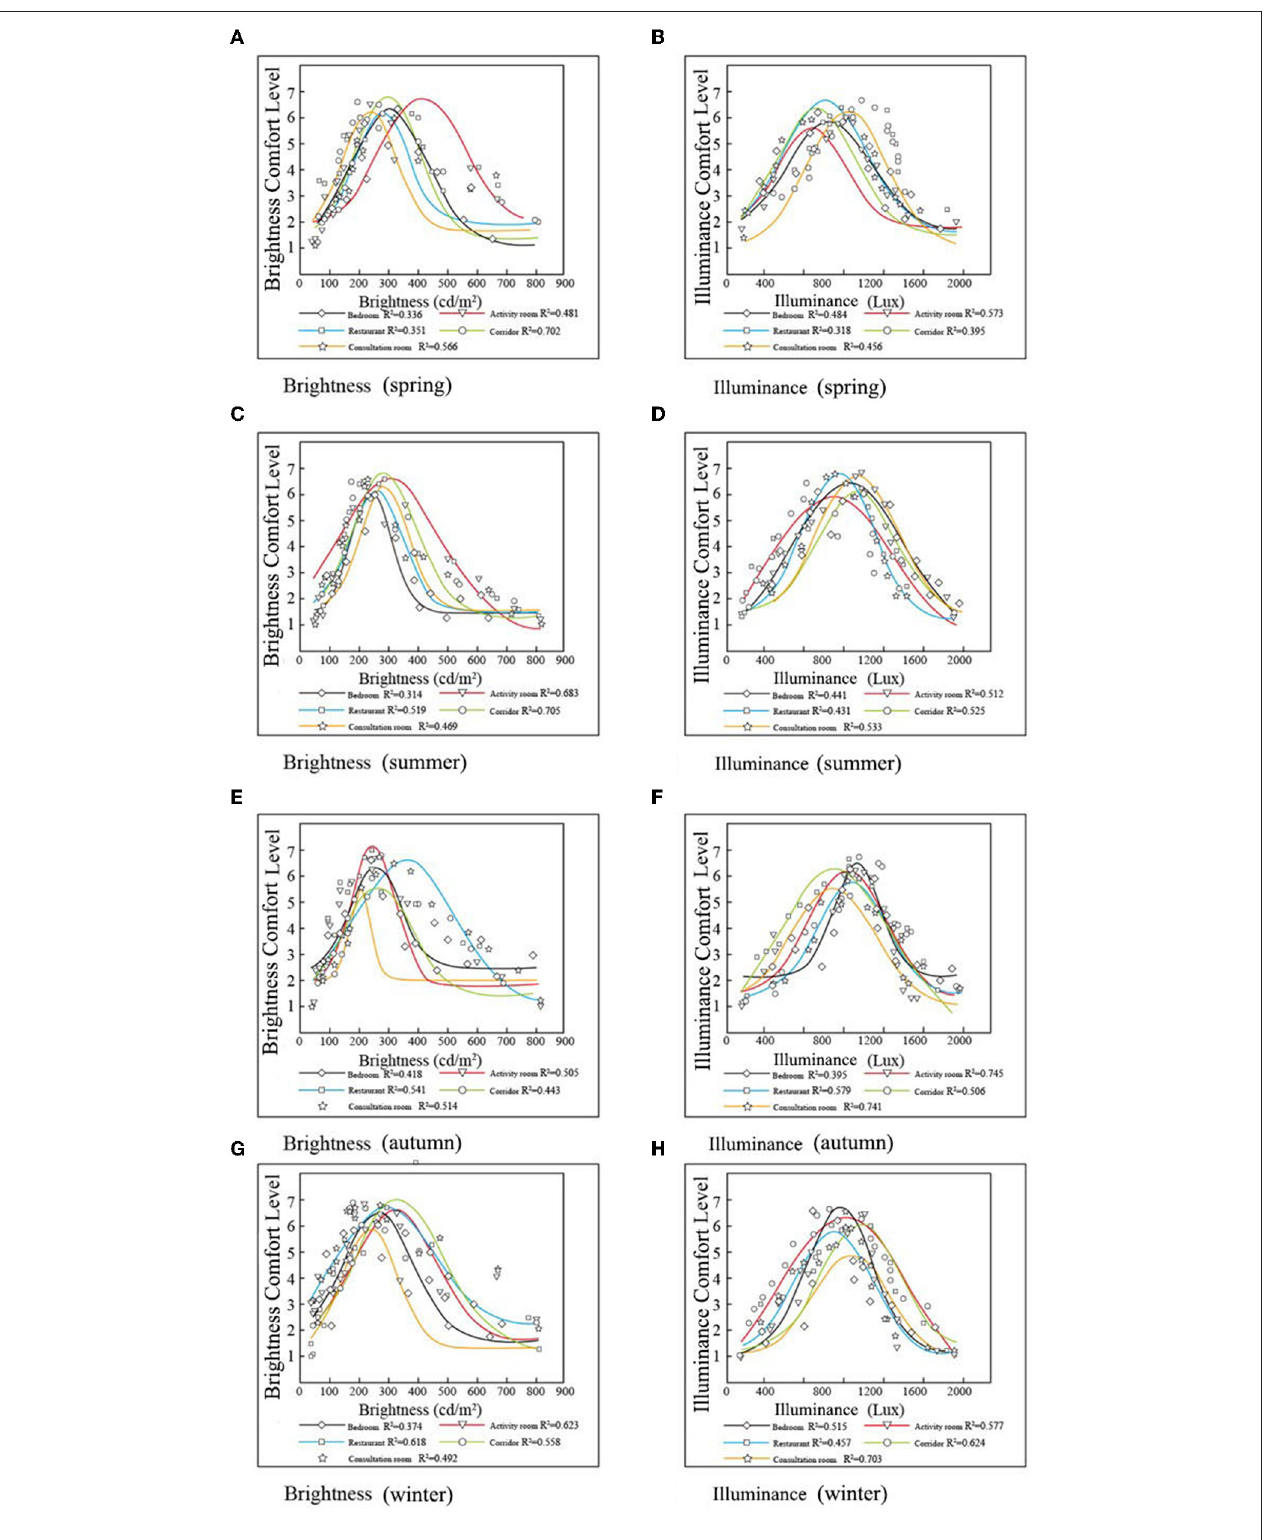
FIGURE 7 | The fit between lighting indicators and lighting evaluation for 4 RECFs. (A) Brightness (spring), (B) Illuminance (spring), (C) Brightness (summer), (D) Illuminance (summer), (E) Brightness (autumn), (F) Illuminance (autumn), (G) Brightness (winter), and (H) Illuminance (winter).